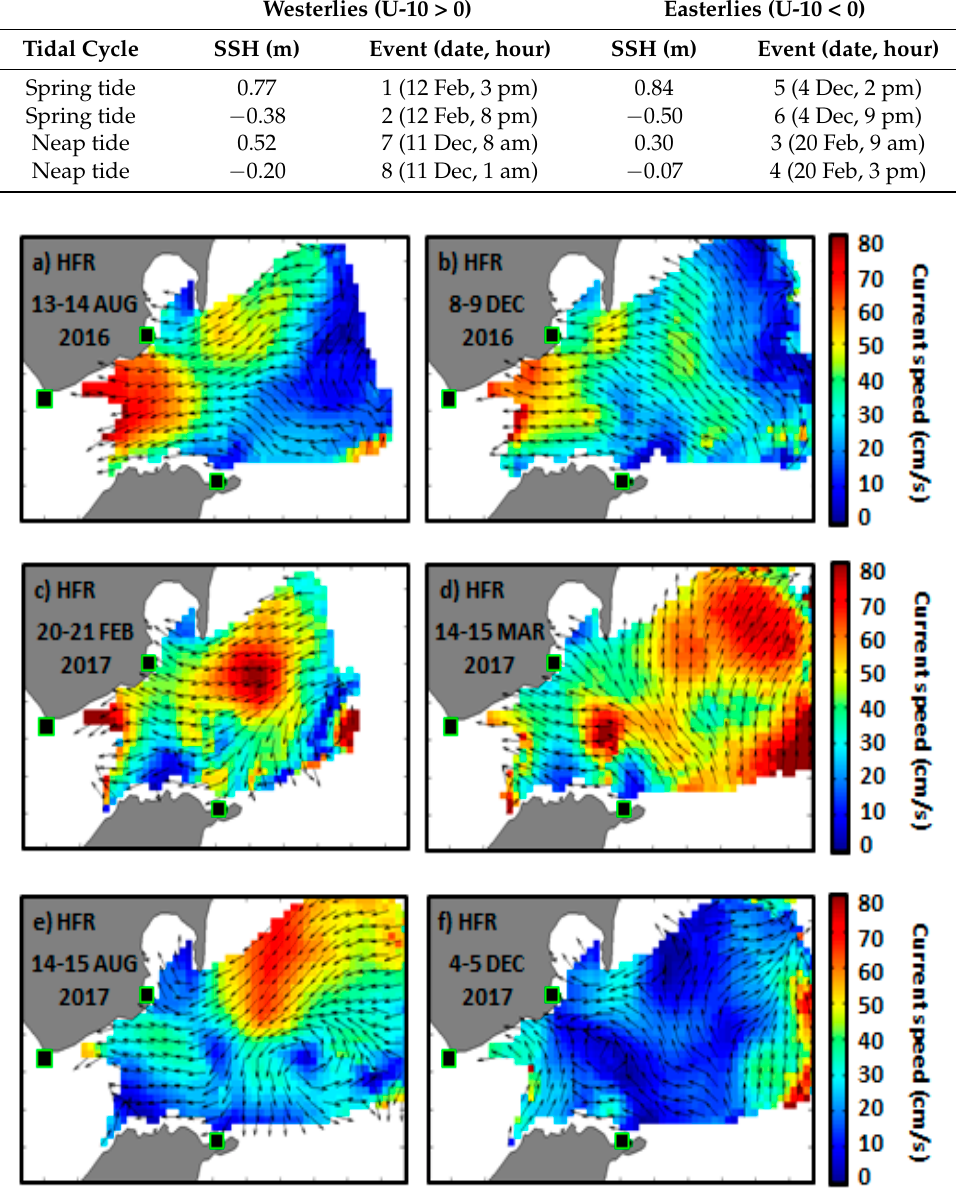
Figure 11. 2-day averaged maps of High-Frequency Radar (HFR)-derived surface circulation for each of the six Atlantic Jet (AJ) inflow reversal events analyzed during the period